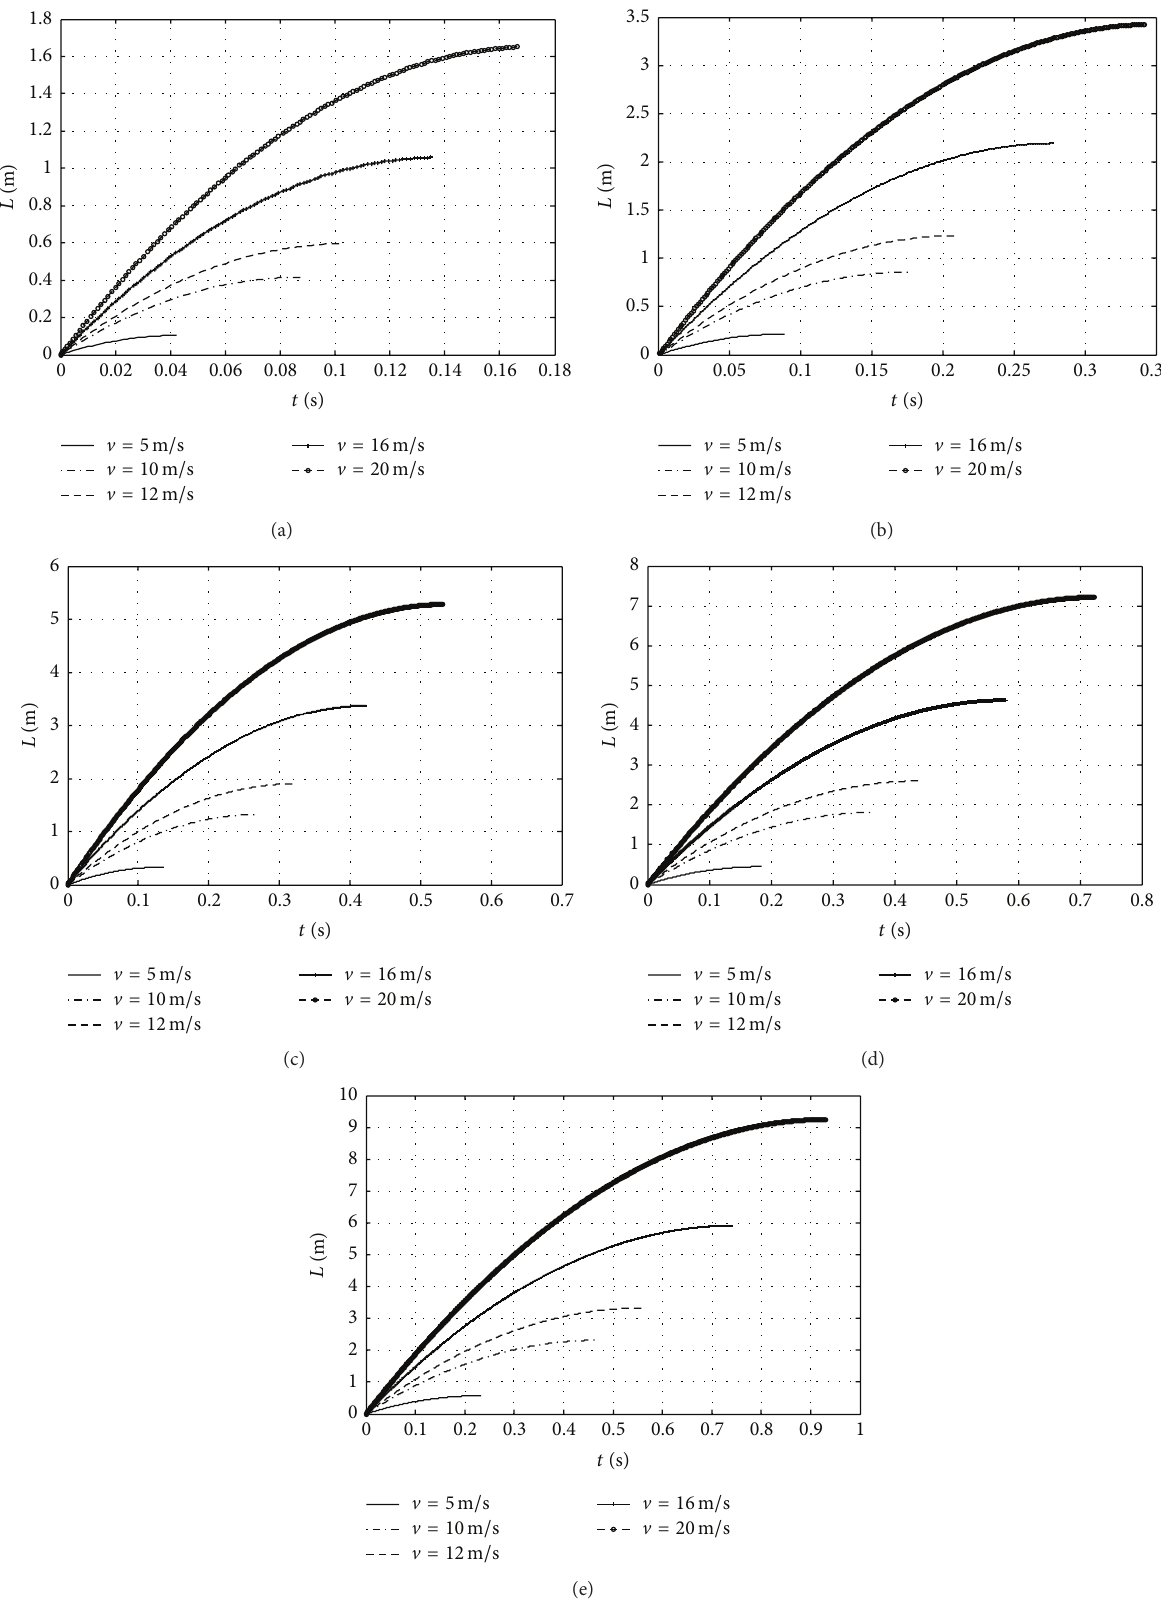
Figure 6: Braking distance change curves of